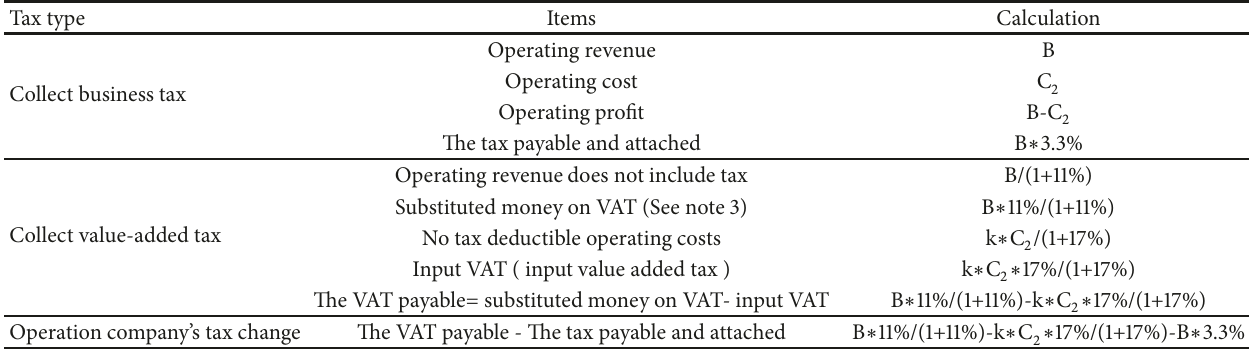
Table 2: The influence of replacing the business tax by a value-added tax pilot on highway projects.